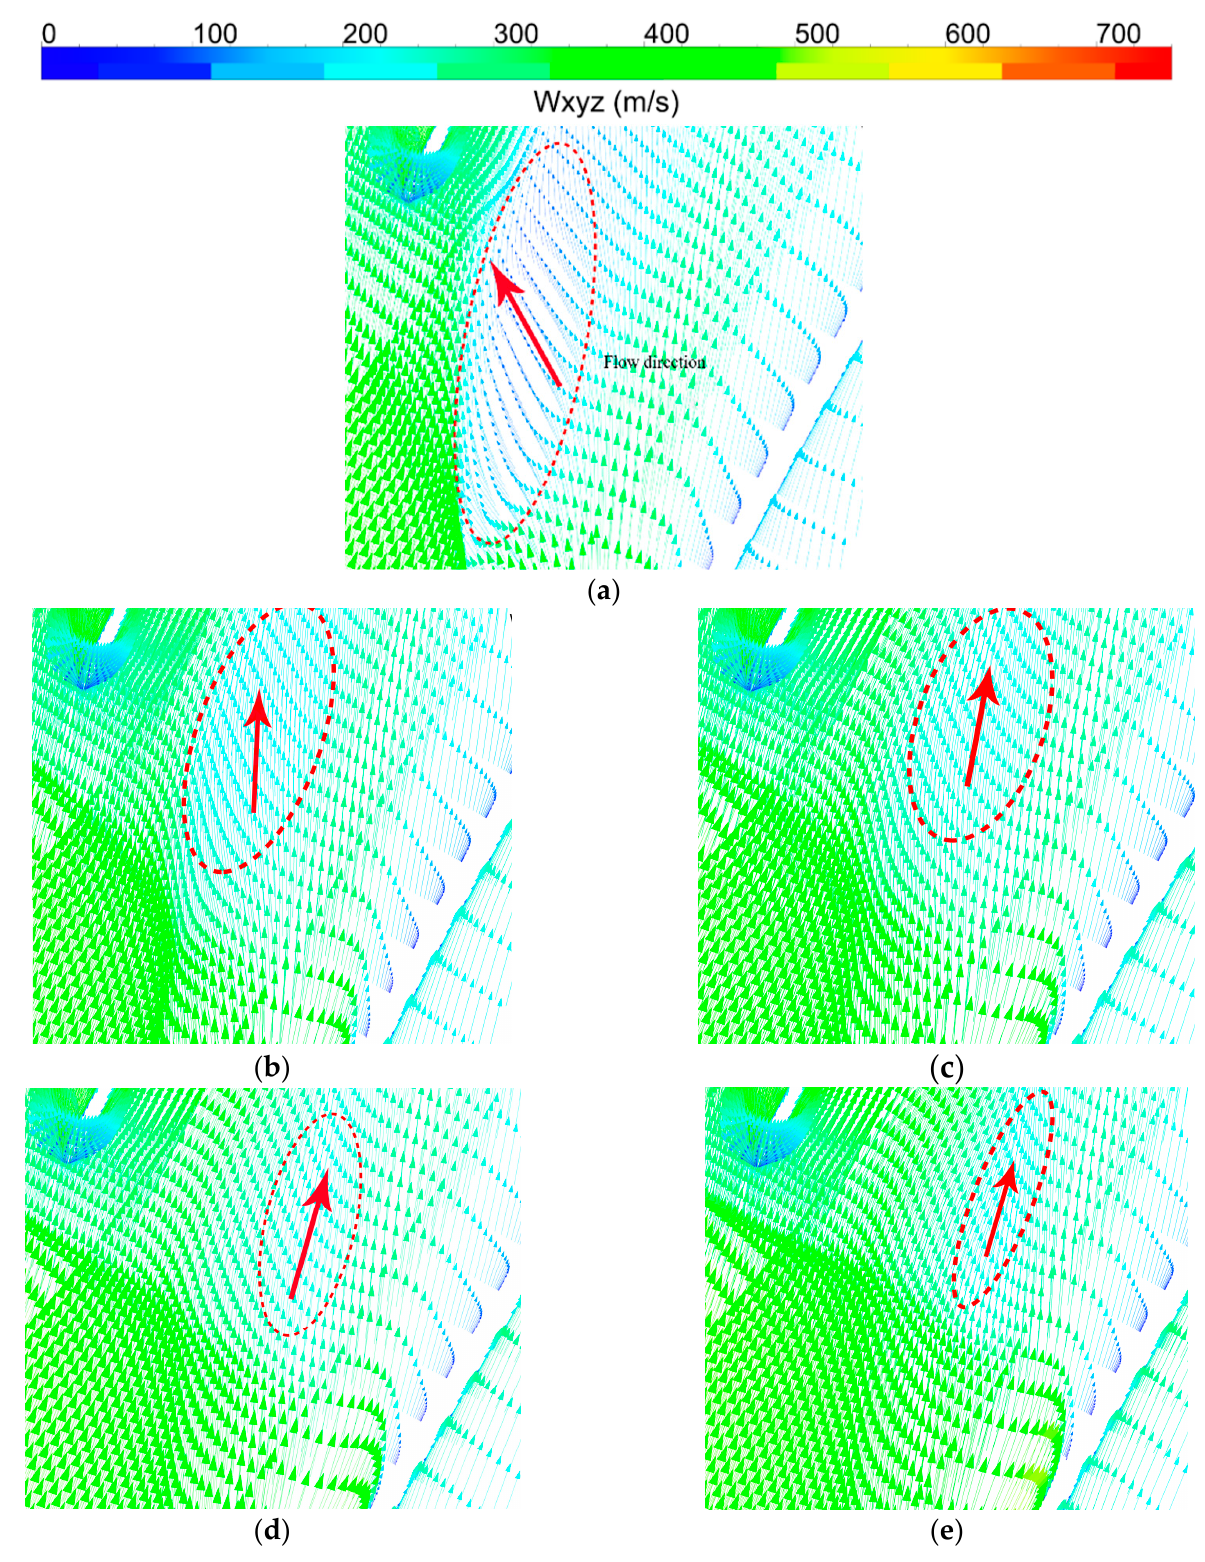
Figure 15. Relative velocity vector of different structure casings at 98% blade span. ( a ) SW. ( b ) SRCC0.36. ( c ) SRCC0.54. ( d ) SRCC0.72. ( e ) SRCC0.9.